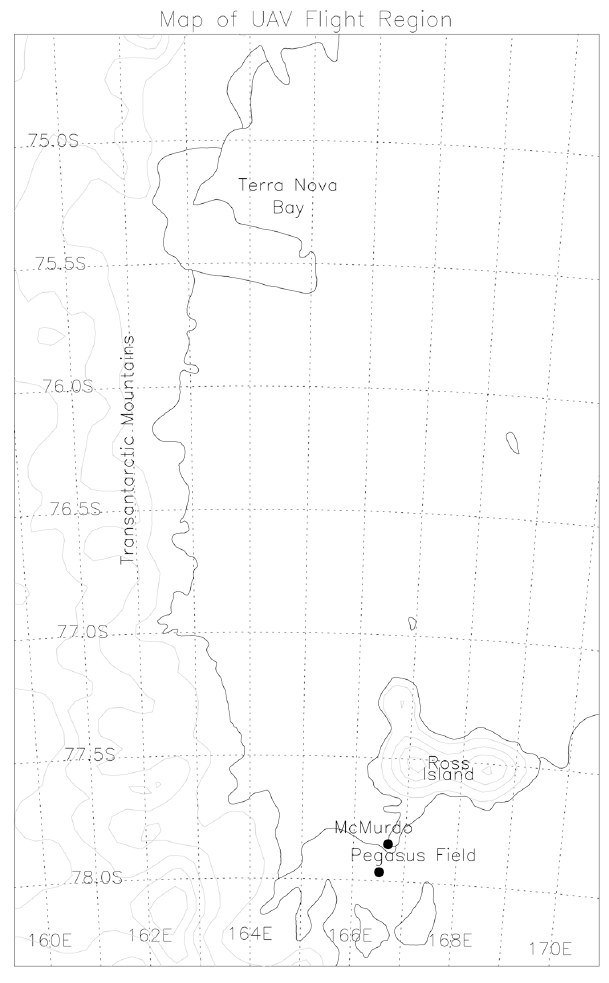
Figure 2. Map of the entire UAS flight region, from Pegasus Run- way to Terra Nova